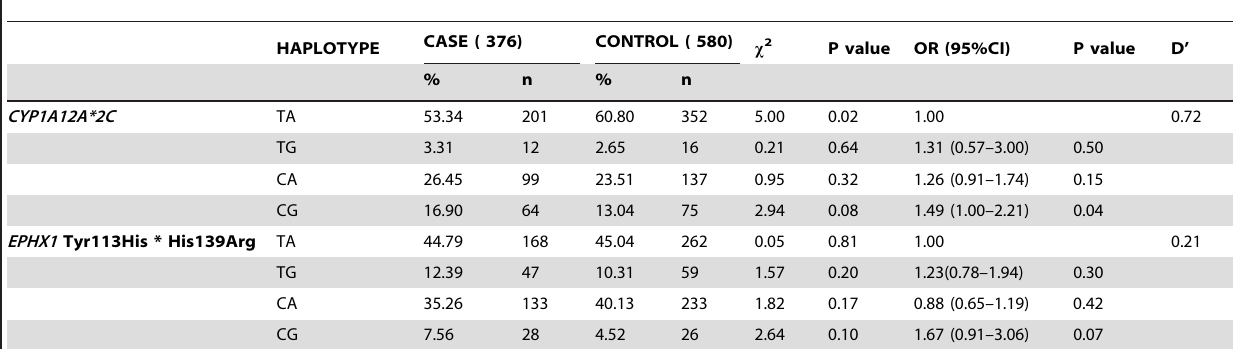
Table 2. Distribution of CYP1A1 and EPHX1 haplotype frequency among lung cancer cases and controls.